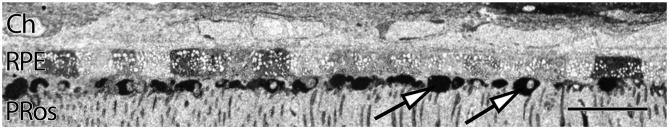
Human parafoveal retina from a 76 year old patient with advanced AMD showing taurine labeling in the RPE internal to the vascular choroid (Ch). Normal levels of taurine in the RPE are typically high and uniform. As RPE cells experience cell stress, they adopt a “bricked” or non-uniform appearance suggesting that they are becoming uncoupled. While this pathology is present to a limited degree in ostensibly normal aged human retina, it becomes much more dramatic in regions of obvious AMD related pathology. The white spots in the RPE likely indicate regions of lipid accumulation and could represent lipofuscin/melanolipofuscin granules. Also of note, are the accumulations of intensely taurine positive deposits underneath the RPE and above the photoreceptor outer segments (arrows). These deposits are not apical processes of the RPE as they have much higher concentrations of taurine than do the RPE cells. Scale bar = 40 μM.